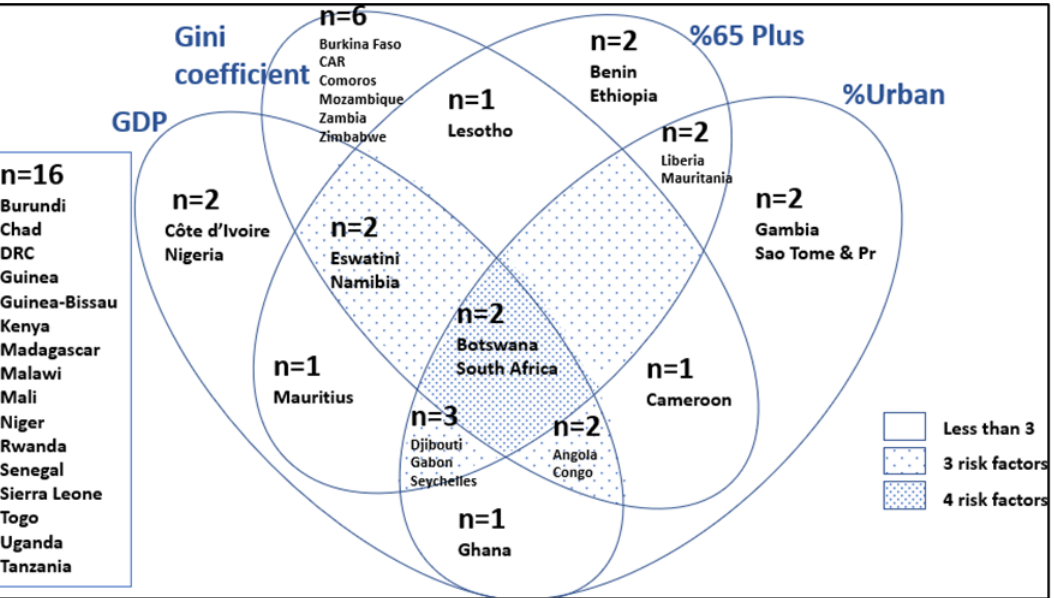
Figure 10. Venn diagram of development indicators for countries in SSA (only those in the top tertile are in the diagram, i.e., 16 are not). %65 Plus = people 65 years and older. are in the diagram, i.e., 16 are not). %65 Plus = people 65 years and